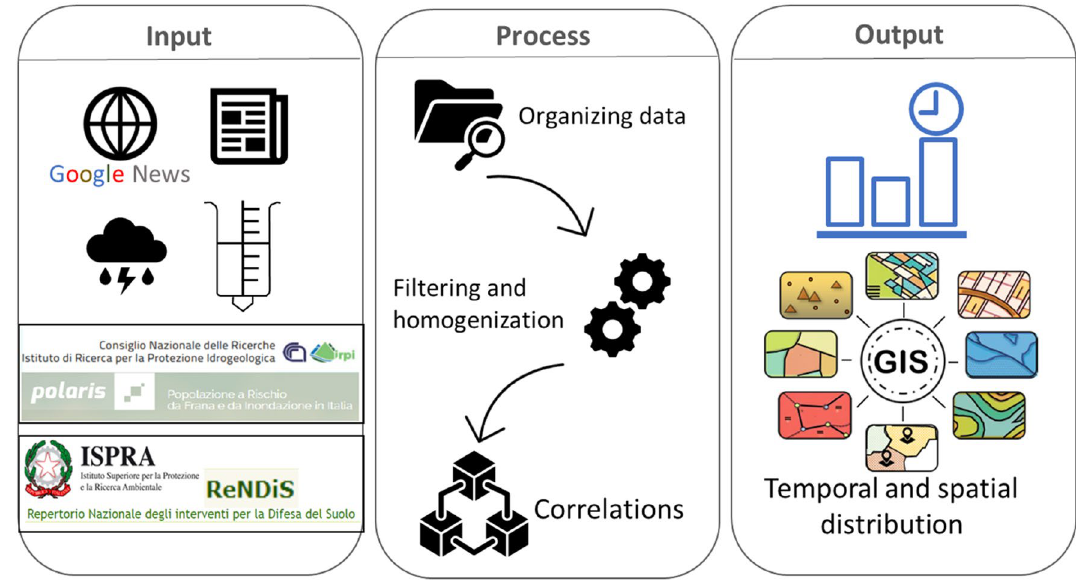
Figure 3. Workflow of the work. The output corresponds to panels and maps to obtain information on approximately 10 years of landslides for the whole Italian